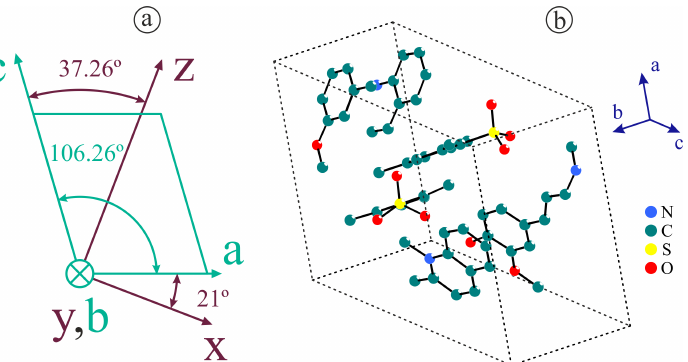
Figure 16. ( a ) Assignment of the crystallographic and principal dielectric axes of the monoclinic formation of HMQ-TMS; ( b ) Crystal structure of DSTMS (the .cif files taken from the CCDC database can be found in the Supplementary Materials).